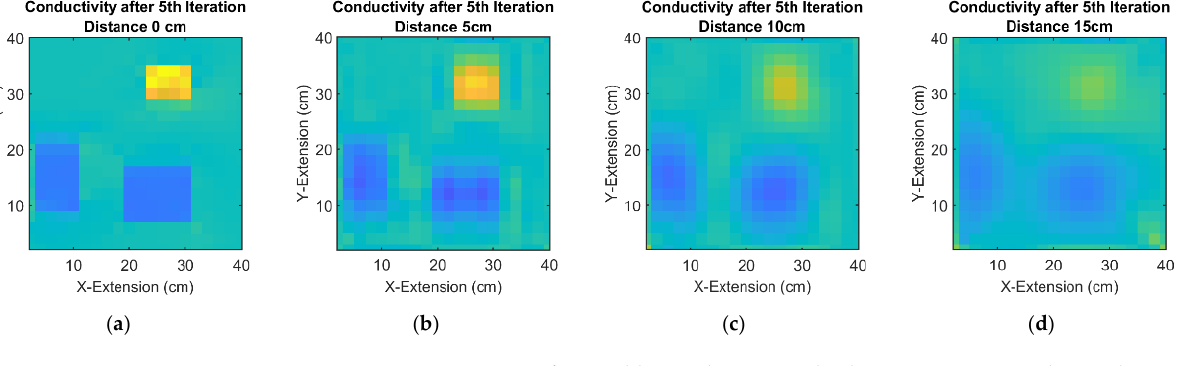
Figure 10. Reconstructions of a weakly conductive and inhomogeneous 2D object, showing the influence of the z-distance between object and receivers: ( a ) Currents are determined by contacting measurement. The only source of imperfections is the non-linear inversion from currents to conductivities; ( b ) Conductivity after the 5th iteration with a 5 cm distance between the measuring body and receiver; ( c ) Conductivity after the 5th iteration with a 10 cm distance between the measuring body and receiver; ( d ) Conductivity after the 5th iteration with a 15 cm distance between the measuring body and receiver.